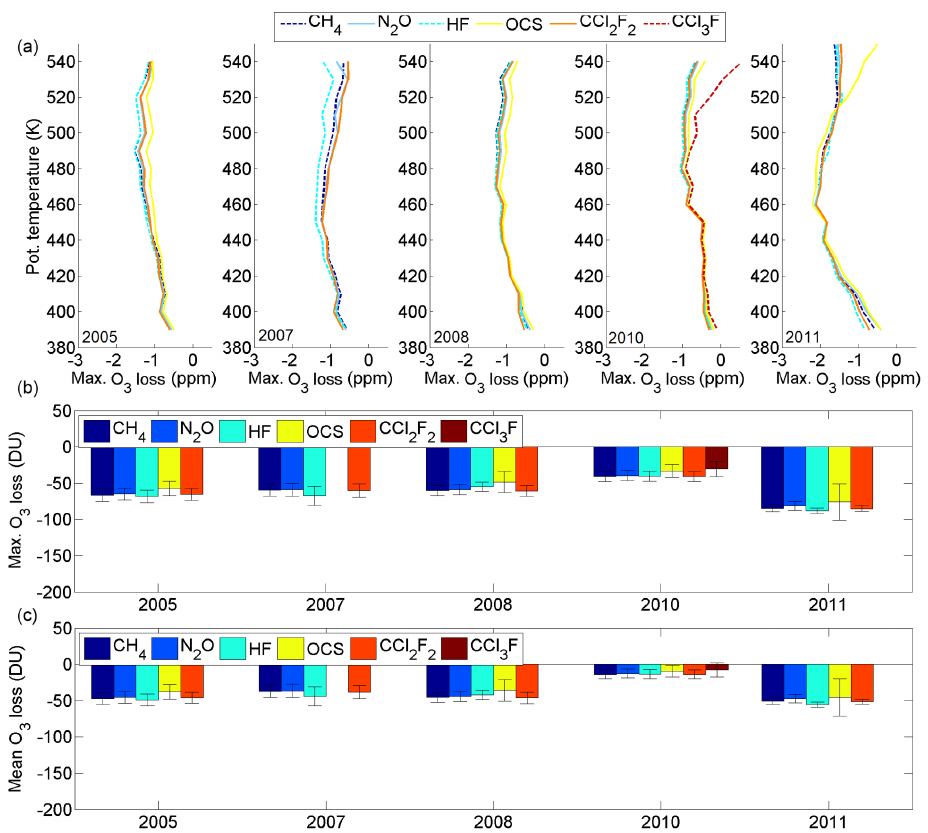
Figure 7. Same as Fig. 6, but for the average vortex profile descent technique.